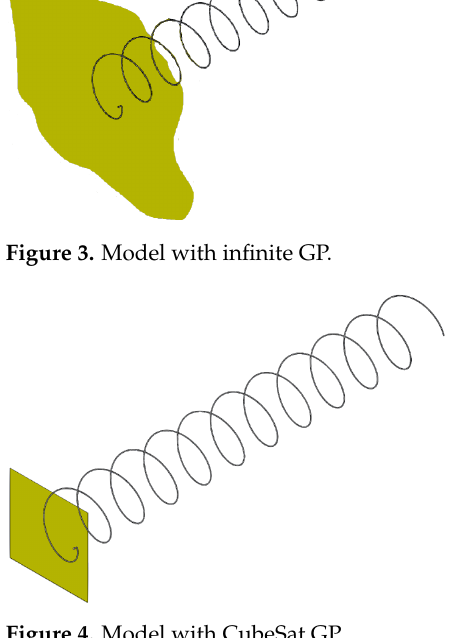
Figure 4. Model with CubeSat